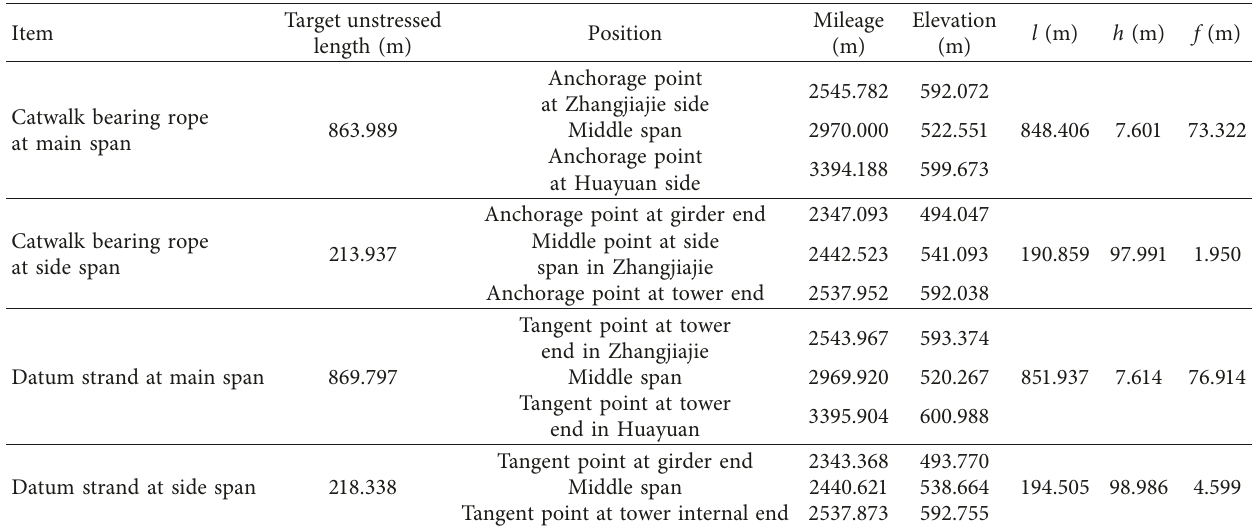
Figure 3: Bridge layout of Lishui Bridge on expressway from Zhangjiajie to Huayuan (unit: Table 4: The target geometry parameters of the datum strand and catwalk bearing rope under erection stage.